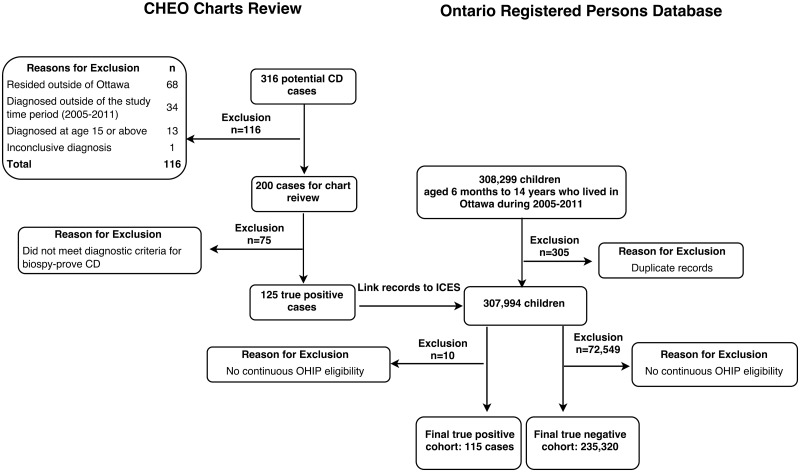
Study flowchart demonstrating the construction of true positive and true negative reference cohort.